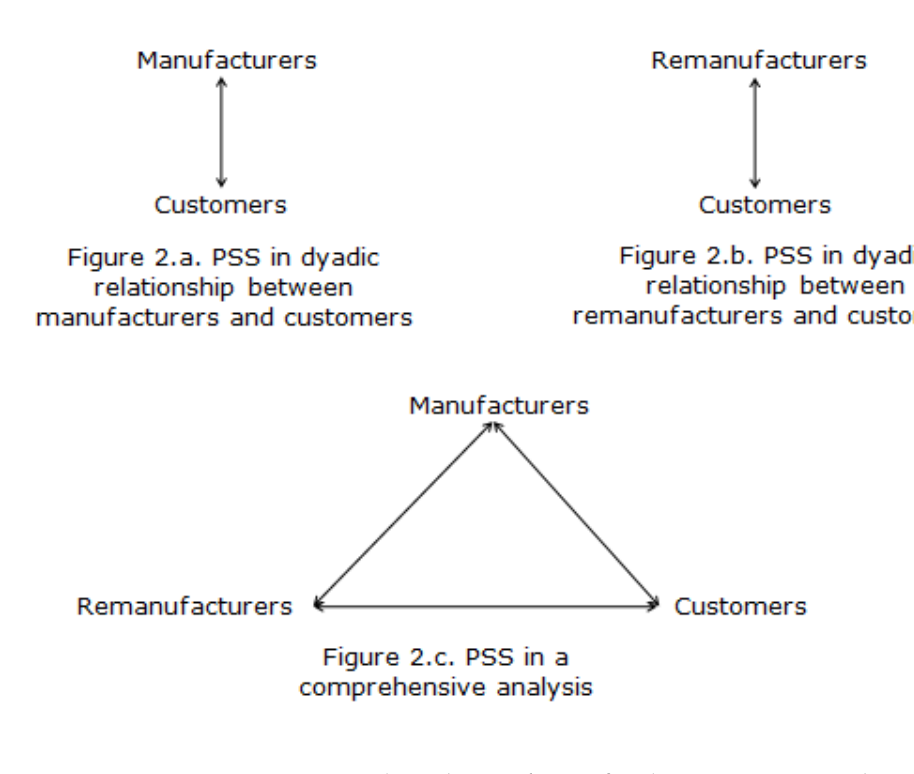
Figure 2. Various relationships as objects of analysis in existing